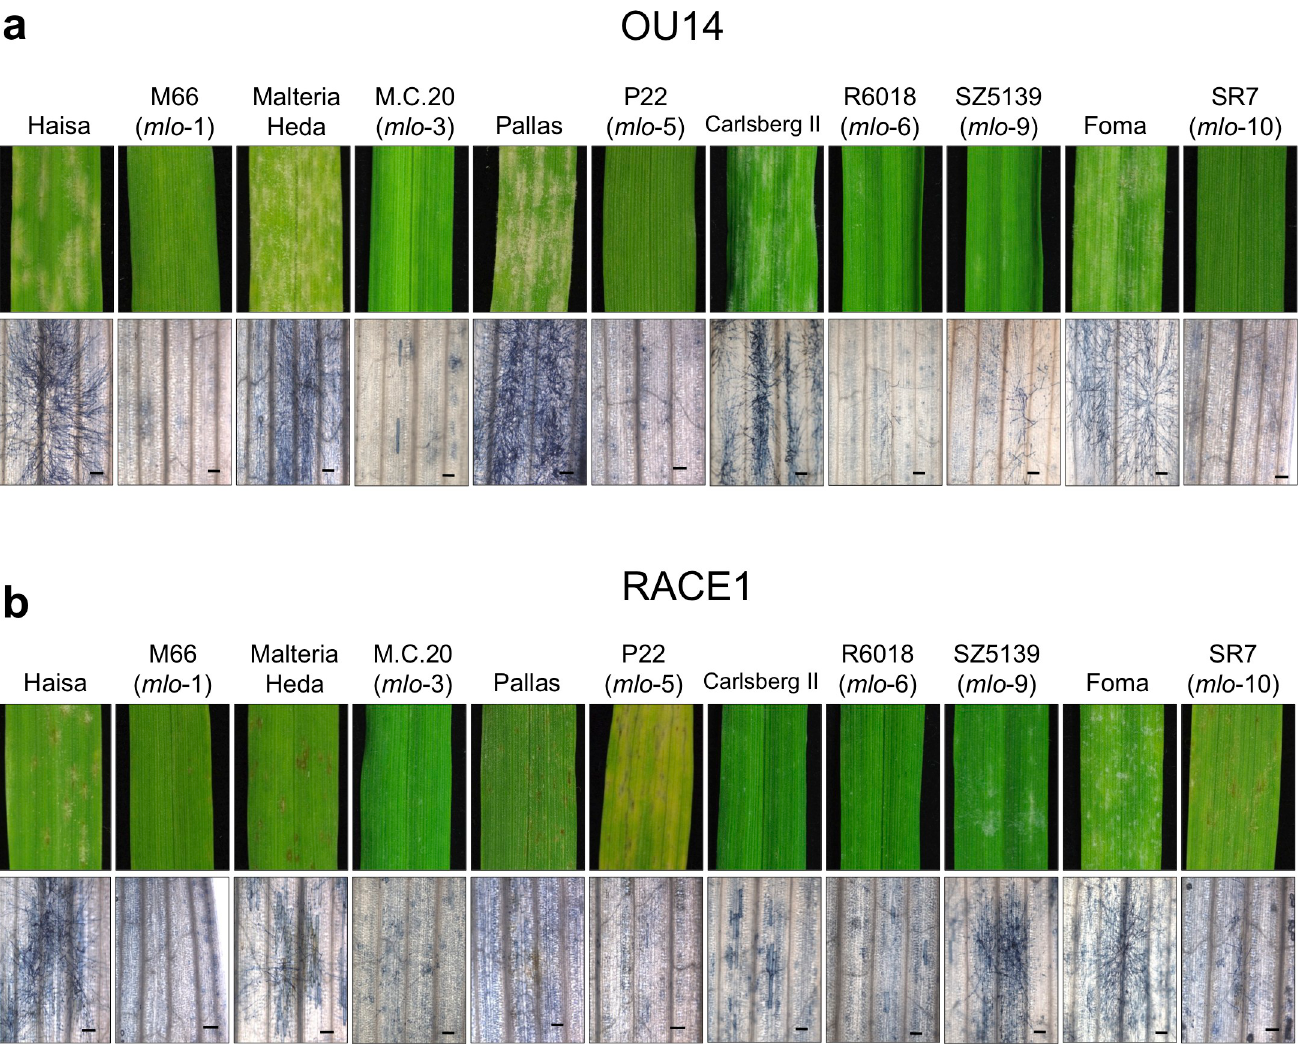
Fig 1. Visible and microscopic phenotypes of the mlo mutants inoculated with two different races of Blumeria graminis f. sp. hordei . Phenotypes of the primary leaves inoculated with OU14 ( a ) and RACE1 ( b ) are shown. To allow for natural inoculation, seedlings were grown for 10 to 14 days in chambers where each Bgh race was maintained. Microscopic observation after trypan blue staining was performed 4 days after inoculation. Scale bars indicate 0.2